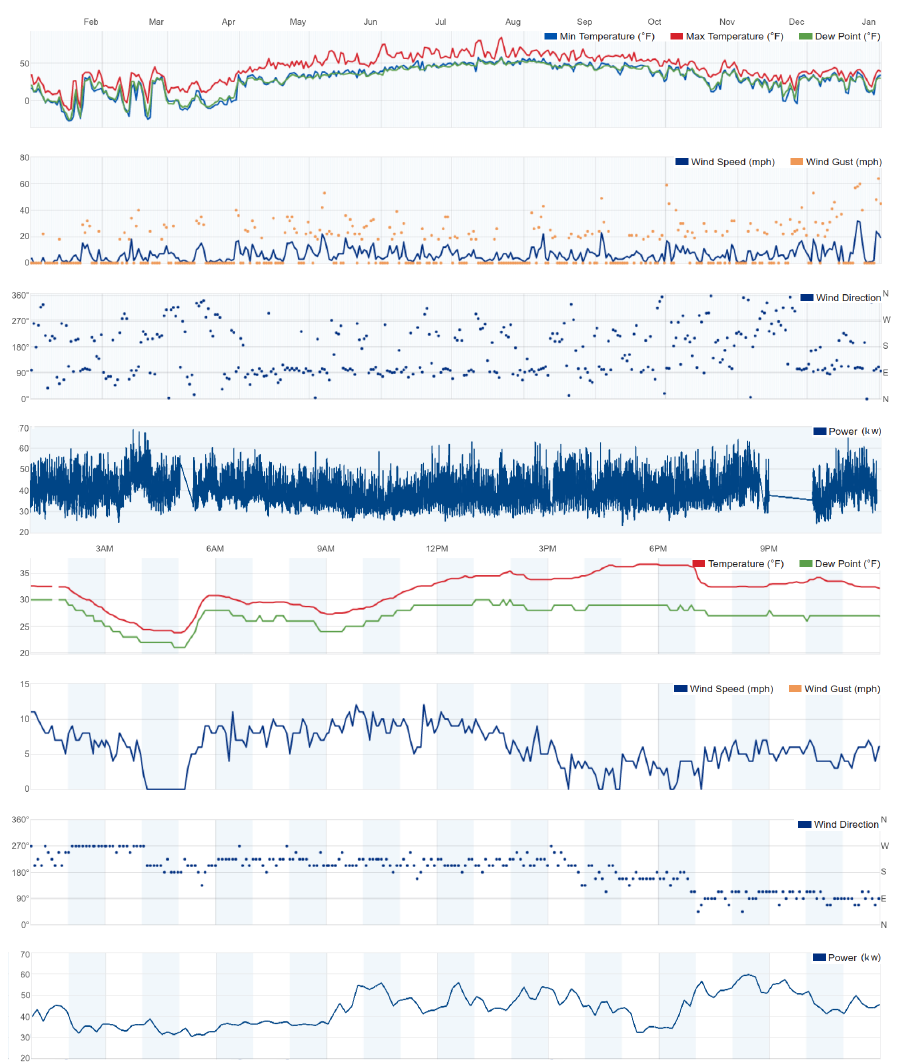
Figure 1. Top : Annual weather conditions at the Igiugig, AK study site. Bottom : Not an uncommon pattern of weather changes in one day. Notice several sudden temperature changes in access of 10 ◦ F occurring over 20 min